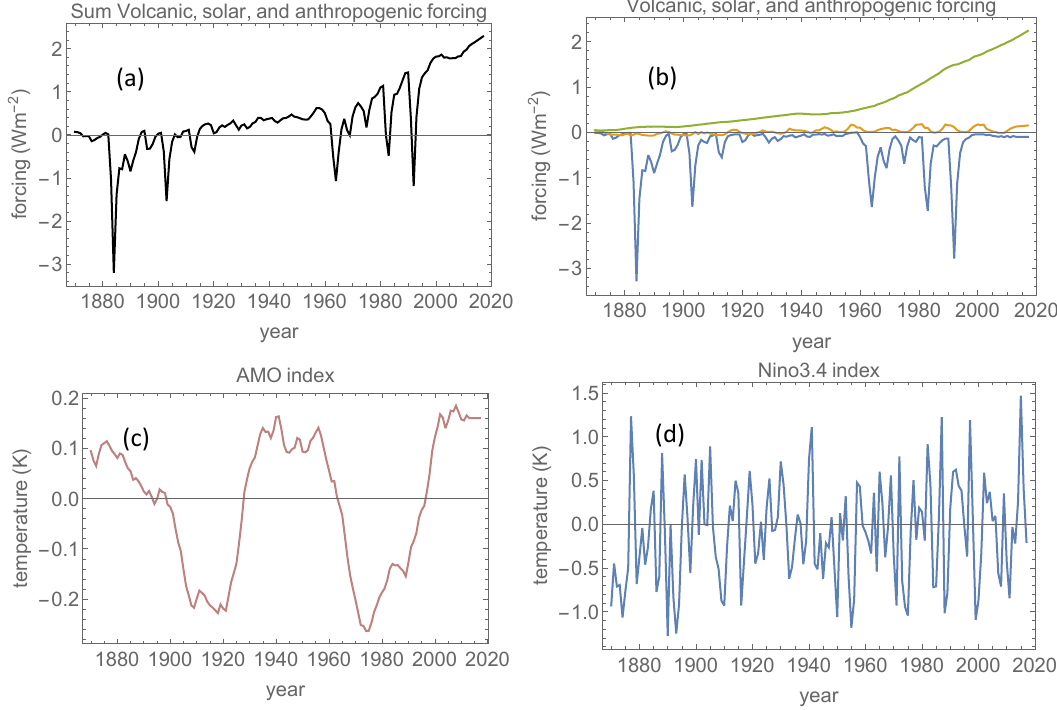
Figure 1. Forcing signals used in the regression analysis. ( a ) The sum of volcanic, solar and anthropogenic forcing. ( b ) The blue curve depicts the volcanic forcing, the yellow curve depicts the solar forcing and the green curve depicts the total anthropogenic forcing, including greenhouse gases, land use change and anthropogenic aerosols. ( c ) The Atlantic Multidecadal Oscillation (AMO) index. ( d ) the Niño3.4 index. These indices are not in units of forcing, but the corresponding forcing is assumed to be proportional to the